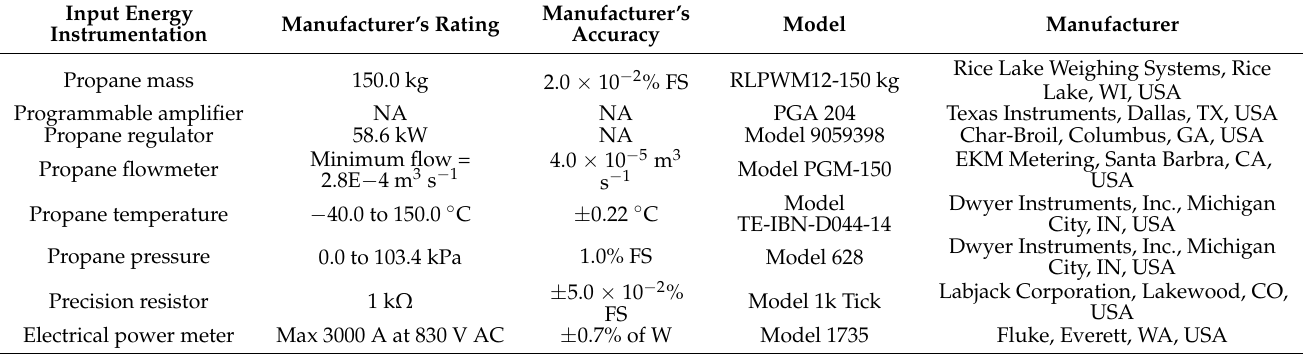
Table 1. Energy input instruments used in the study in order as described in the text. FS = Full